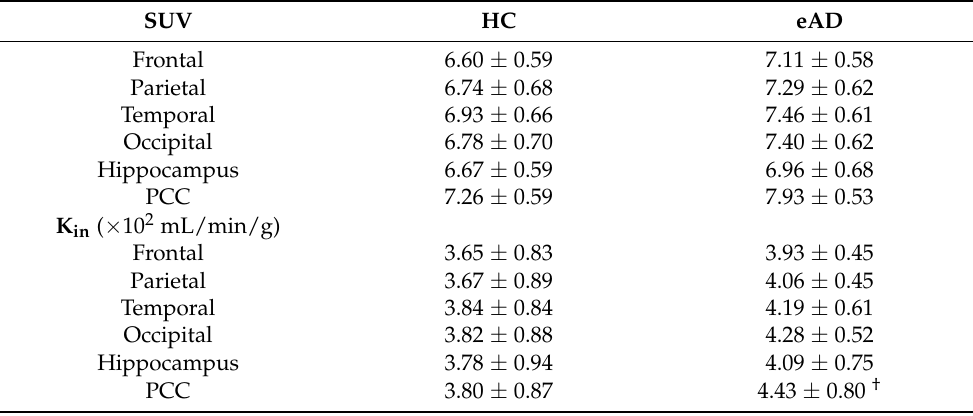
Table 2. Regional parametric values of SUV, K in , and k 3 in each group (mean ± SD).